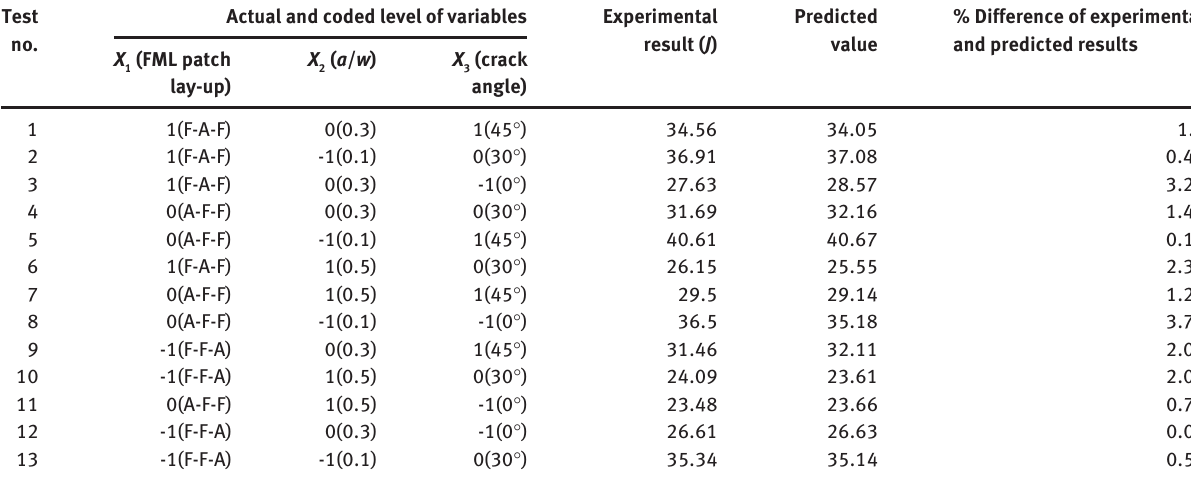
Table 9 Results of the experimental tests and predicted results obtained from RSM. Test